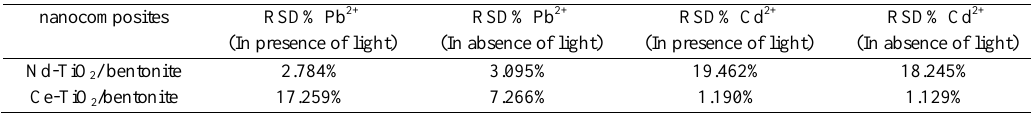
Table 6. Langmuir and Freundlich isotherm constants for the adsorption of lead (II) and cadmium